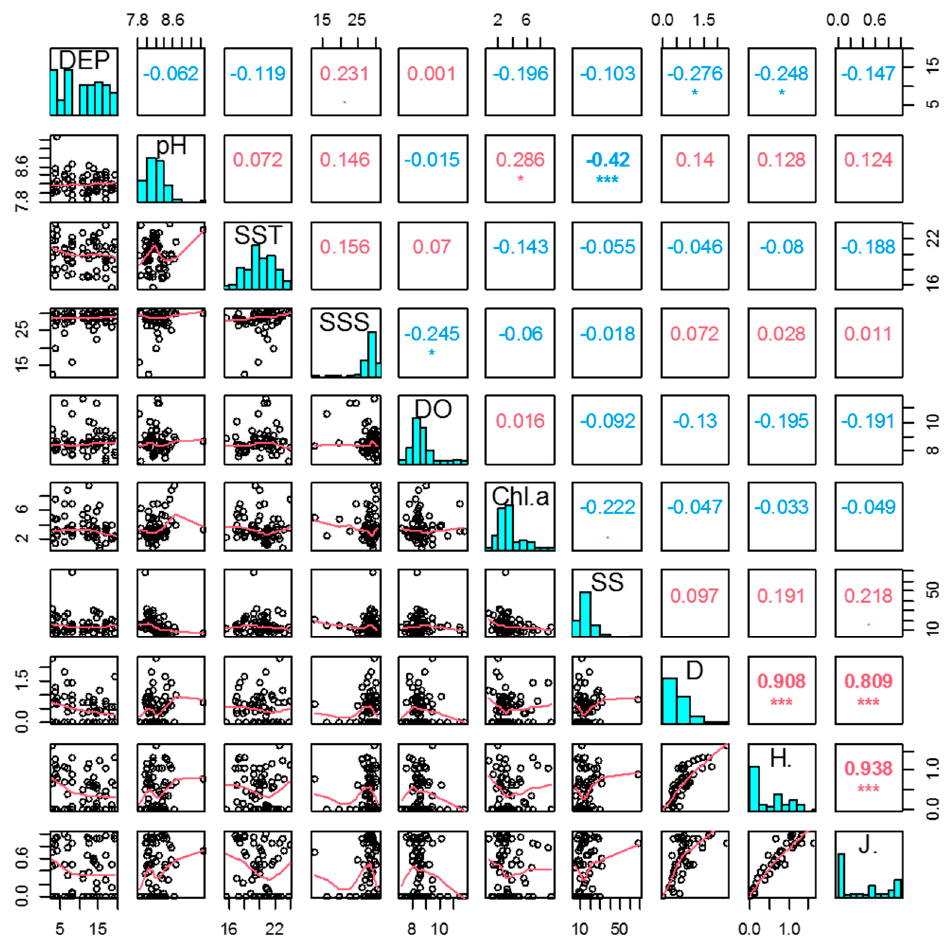
Figure 8. Pearson correlation matrix showing comparisons of the diversity of fish eggs, larvae, and environmental factors. *: p < 0.05, ***: p < 0.001. Histogram shows the frequency distribution of factors, black circles indicate bivariate plots, and red lines indicates smoothing curves for bivariate plots. SST = sea surface temperature, SSS = sea surface salinity, DEP = depth, DO = dissolved oxygen, Chl–a = chlorophyll–a, SPM = suspended particle matter, pH = acidity.